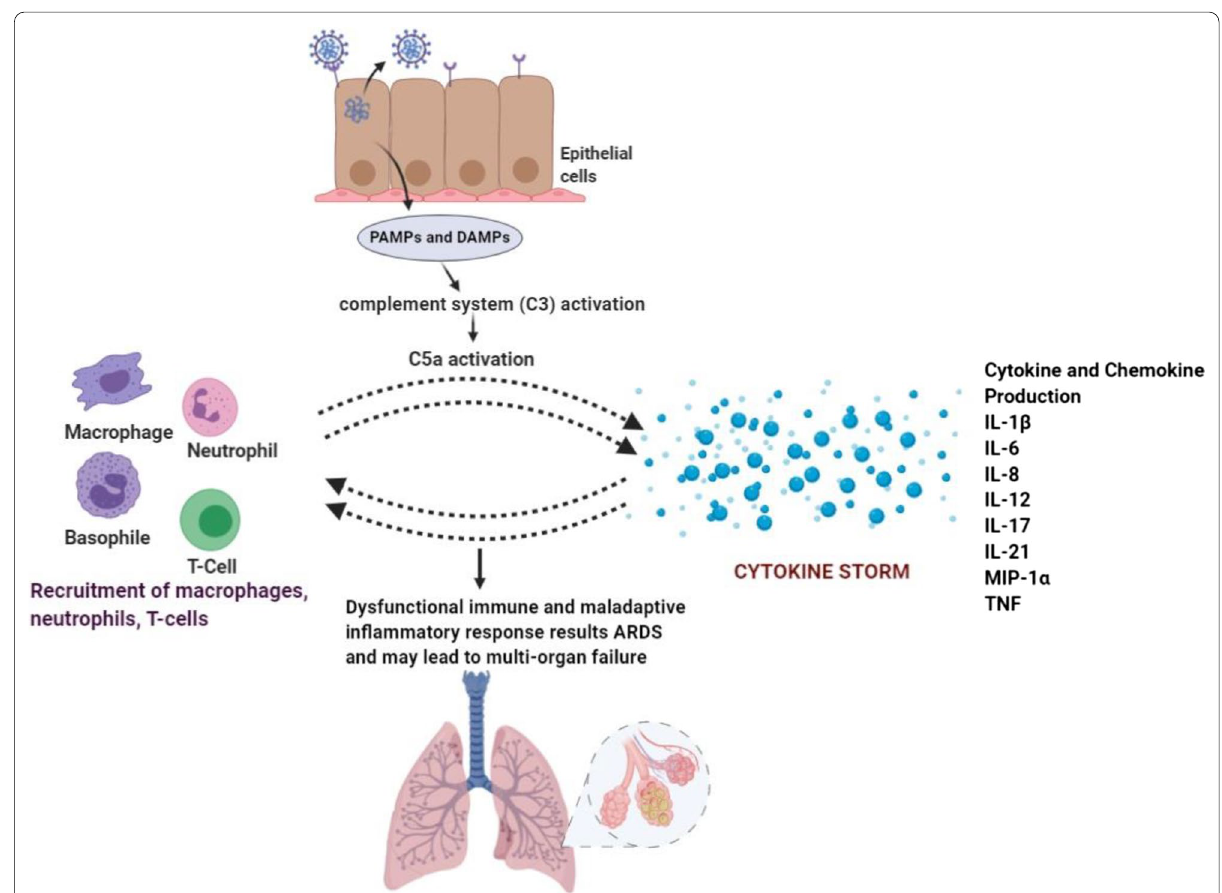
Fig. 3 Dysfunctional host immune response against SARS-CoV-2 can cause the disease more